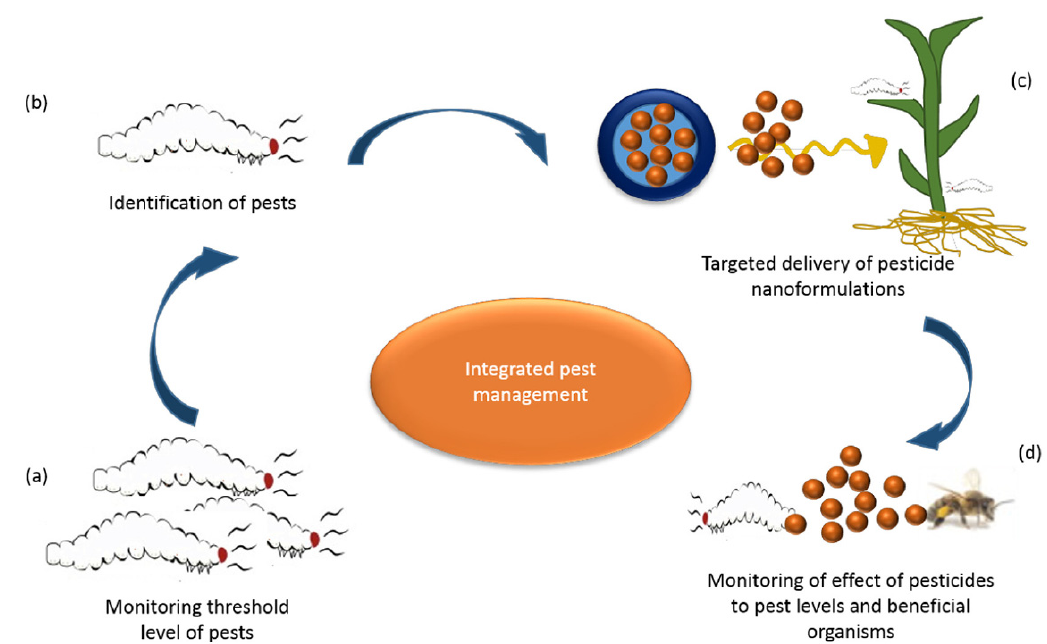
Figure 5. Possible application of nanotechnology in the management of pests: ( a ) monitoring threshold pest levels; ( b ) pest identification; ( c ) pesticide delivery; and ( d ) monitoring the effects of nano-pesticides on the level of pests. Reproduced with permission from [112]. Elsevier, 2018 Table 2. Different studies based on nano-pesticide application. Sl.